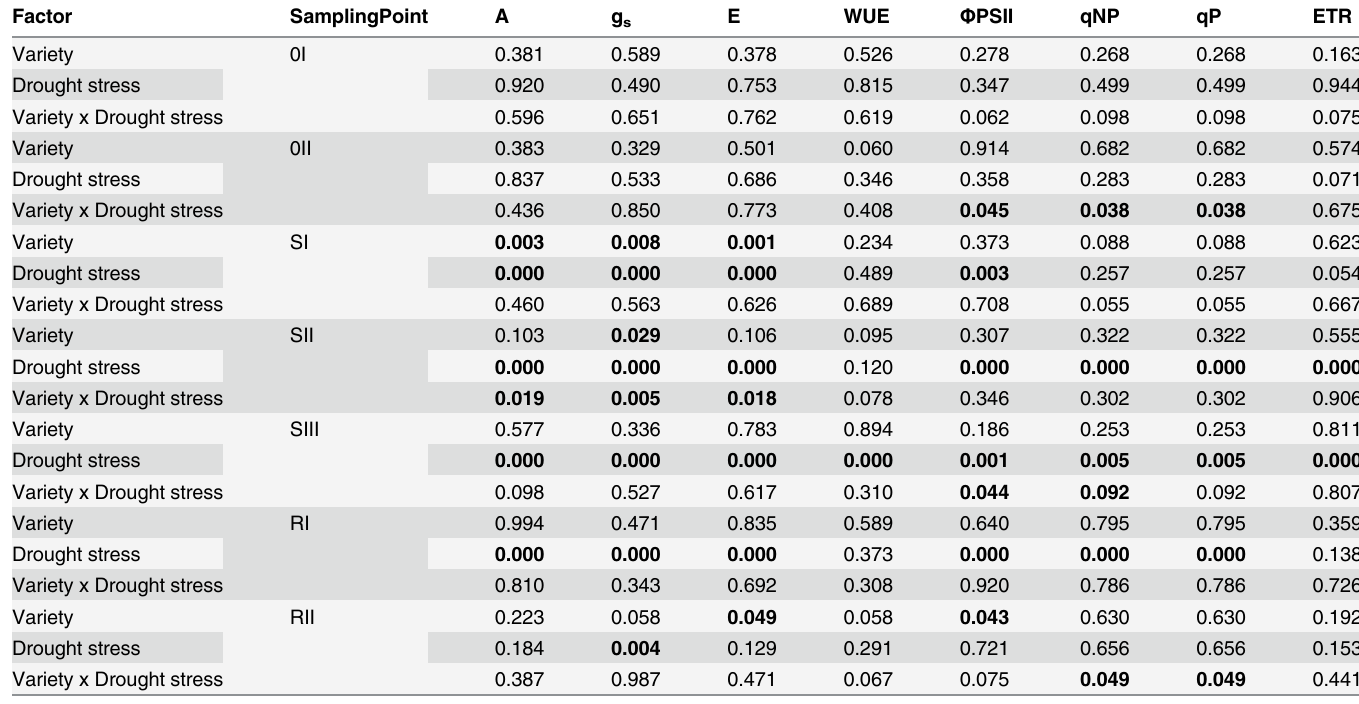
Table 4. Two-Way ANOVA on gas exchange and chlorophyll fl uorescence parameters, for each measurement date in the growth chamber experiment. 0I, 0II = before the beginning of the drought treatment; SI, SII, SIII = corresponding to 4, 5 and 6 d from the last irrigation of the drought stressed sets, respectively; RI, RII = corresponding to 2 and 4 d after re-irrigation of the drought stressed